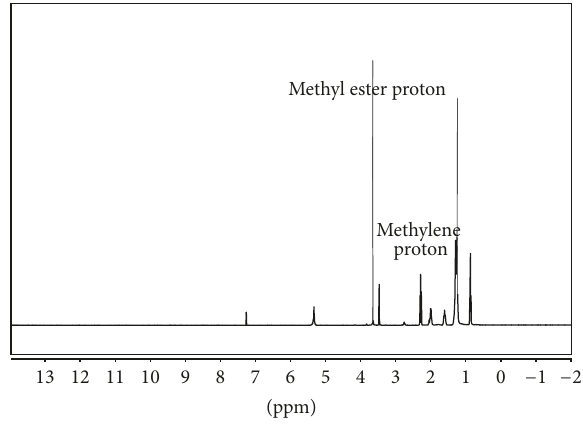
Figure 1: 1 H-NMR spectrum of WCO